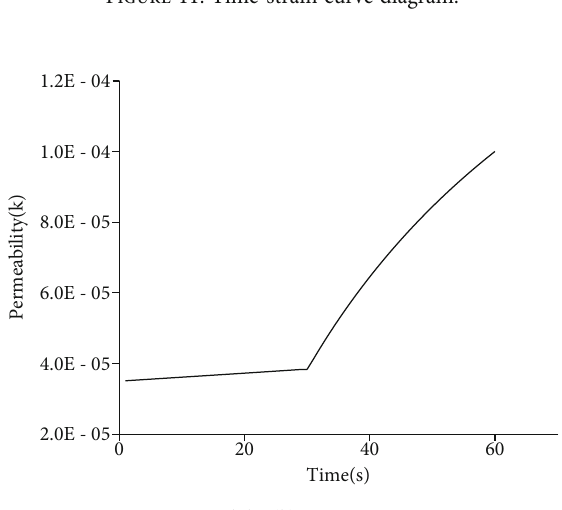
Figure 13: Variation curve of the F value of gas-bearing